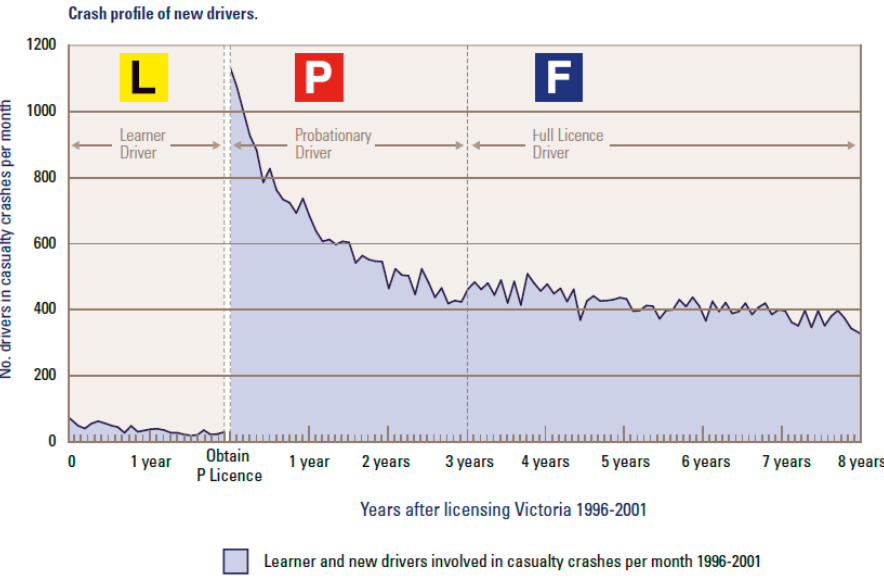
Figure 1. Low crash rates during the learner period, highest rates at licensure, with rapid declines